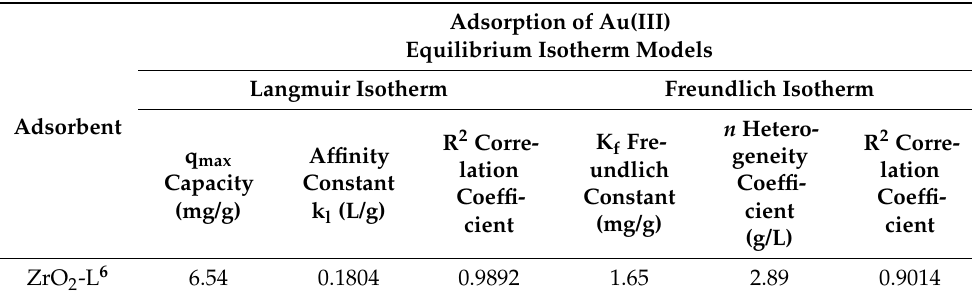
Table 4. Langmuir and freundlich isotherm parameters for the adsorption of Au(III) on ZrO 2 -L 6 .